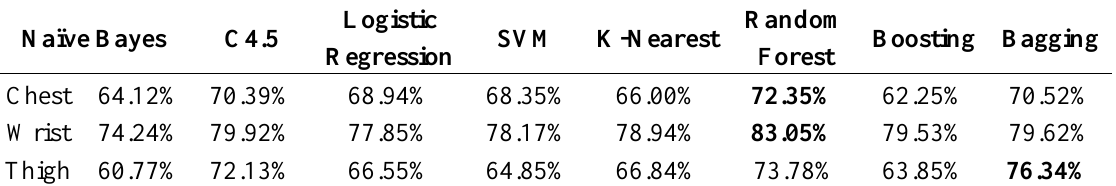
Table 5. Classification accuracy for (Sudden—Sustained) using LOOCV. Naïve Bayes Chest Wrist Thigh Table 6. Classification accuracy for (Bound—Free) using LOOCV. Naïve Bayes Chest Wrist